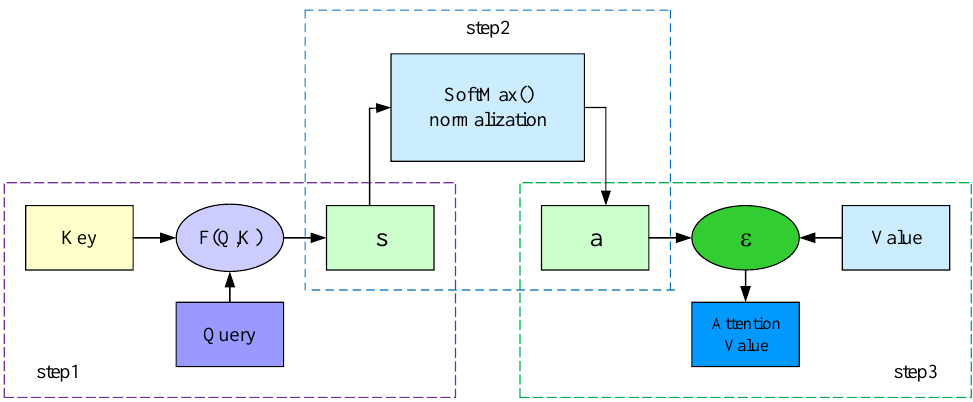
Figure 5. Internal calculation process diagram of the attention mechanism.